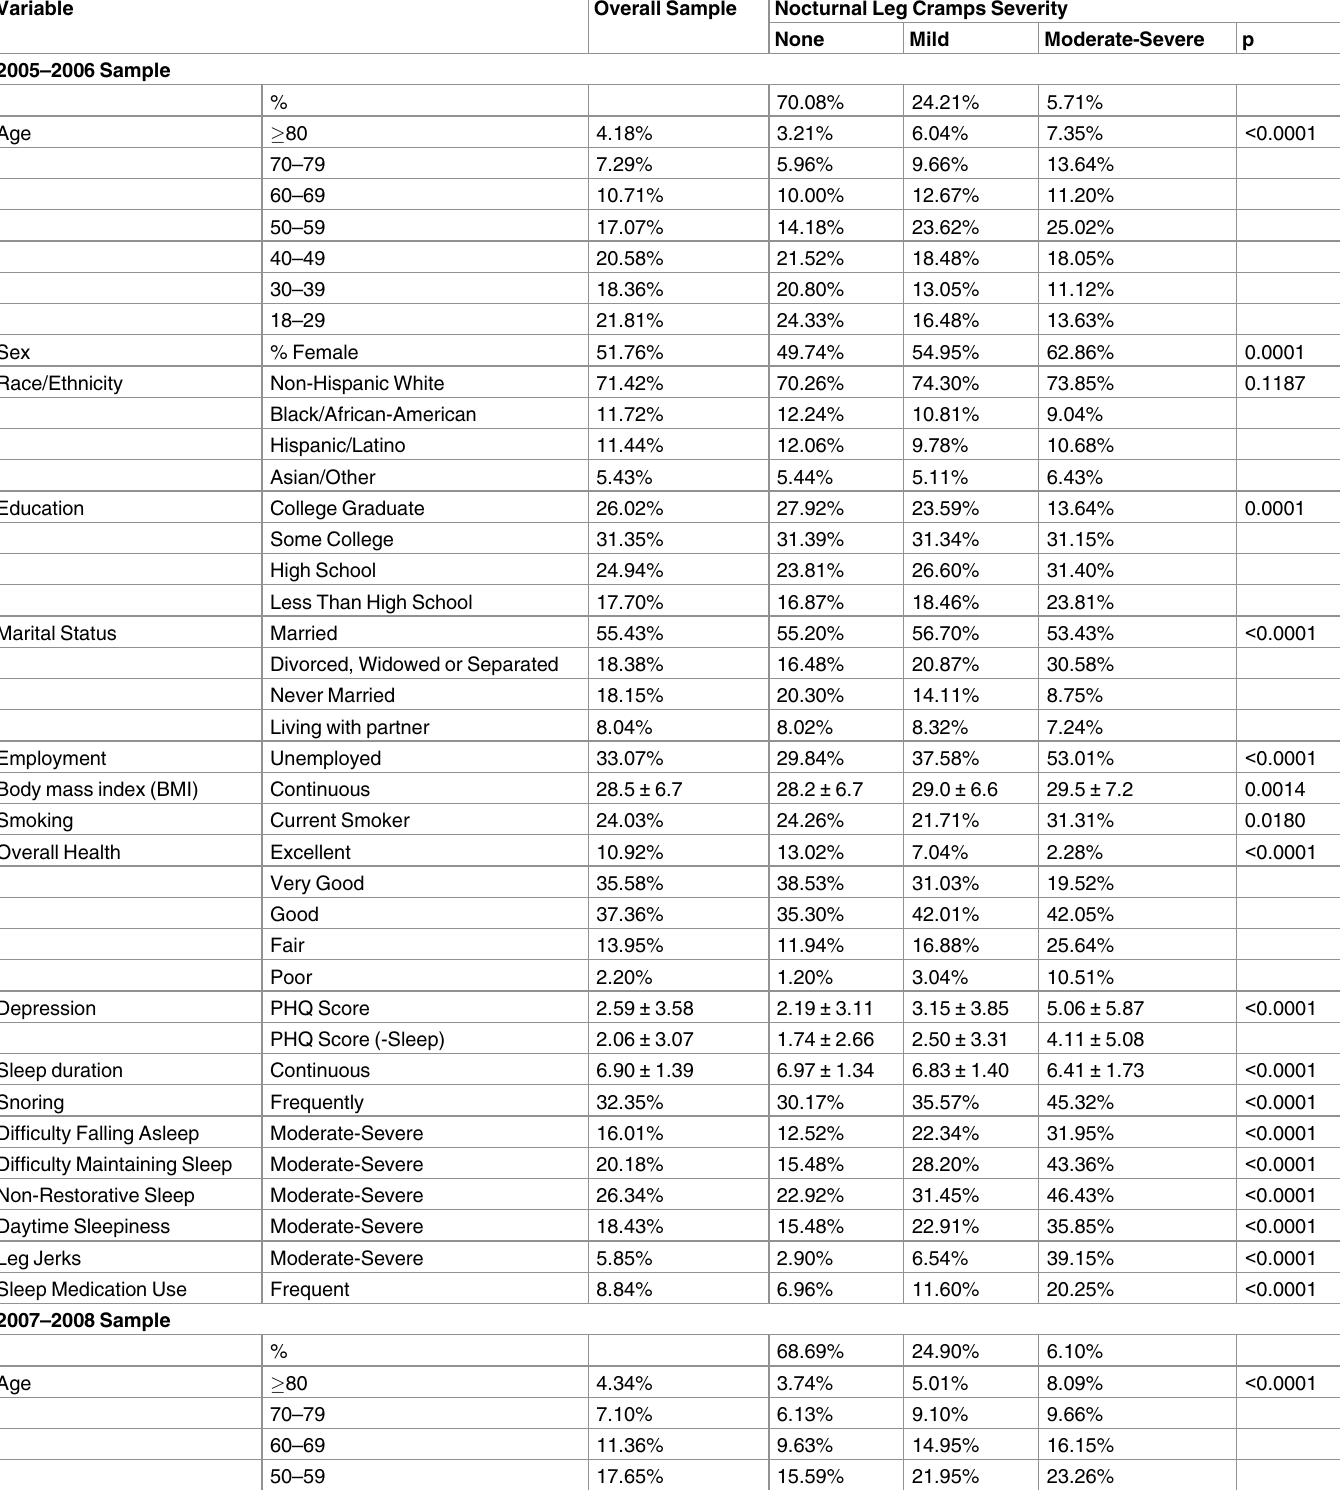
Table 1. Characteristics of the sample, stratified by dataset and severityof nocturnal leg cramps.